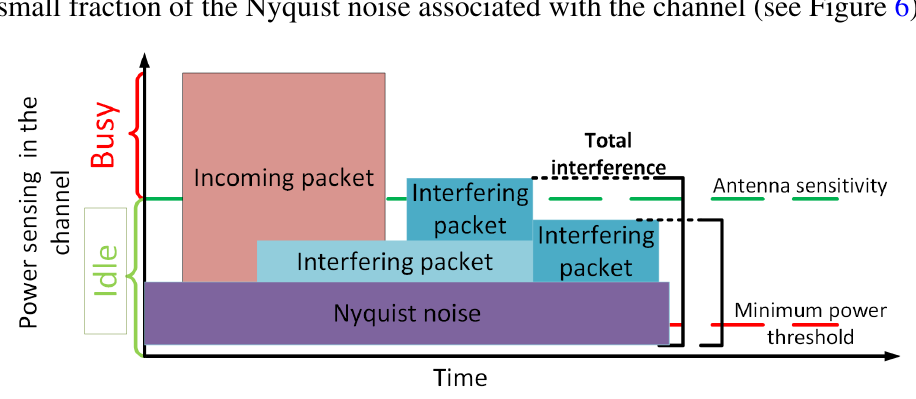
Figure 6. State of the channel and interference management of a wireless channel for a node in a network simulator